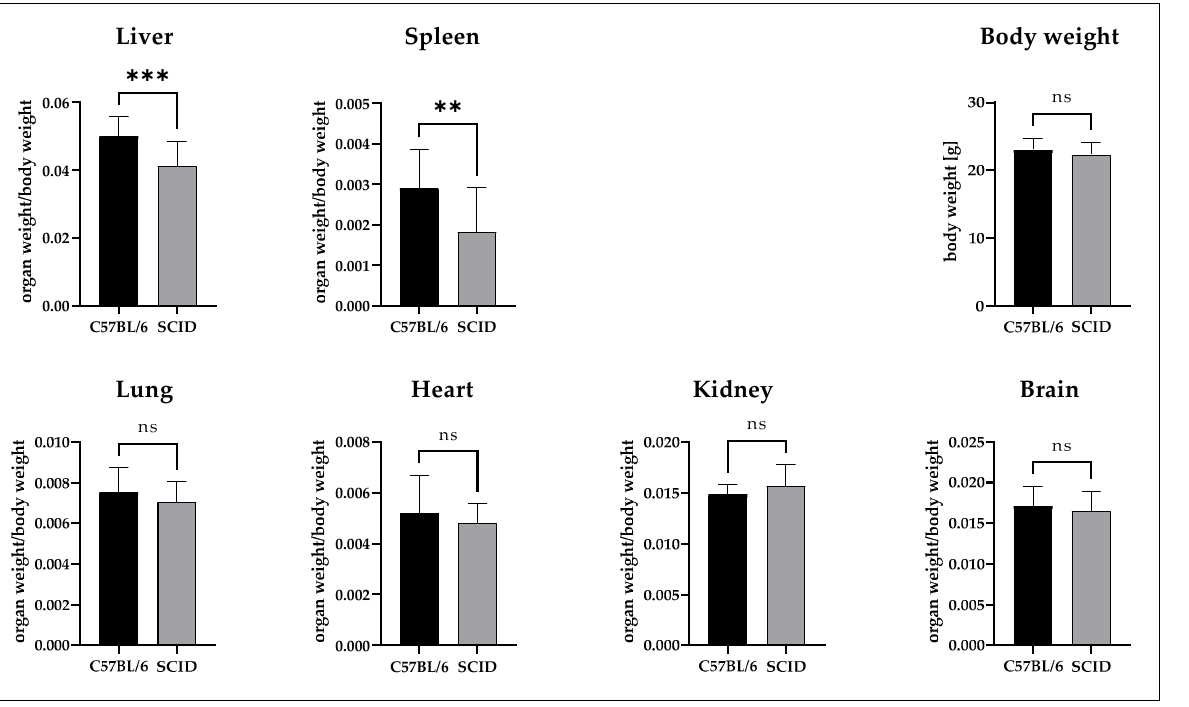
Figure 3. Comparison of the weights of various relevant organs in the mouse models C57BL/6 and SCID. For the mice models equal average body weights were observed. The organ weights were normalized to the respective individual body weight. A significant difference was detected for liver and spleen, while for lung, heart, kidney and brain no relevant differences could be observed. ** p < 0.005; *** p < 0.0005; ns = not significant.